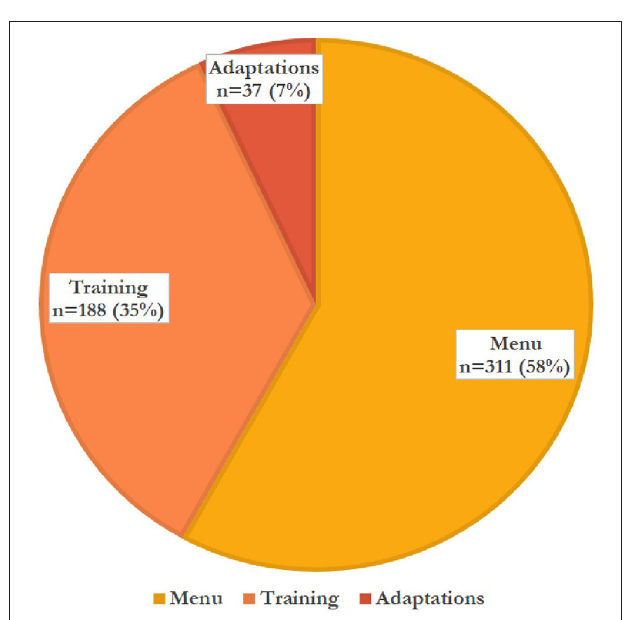
FIGURE 2 | Menu, training, and adapted techniques used by teachers n =